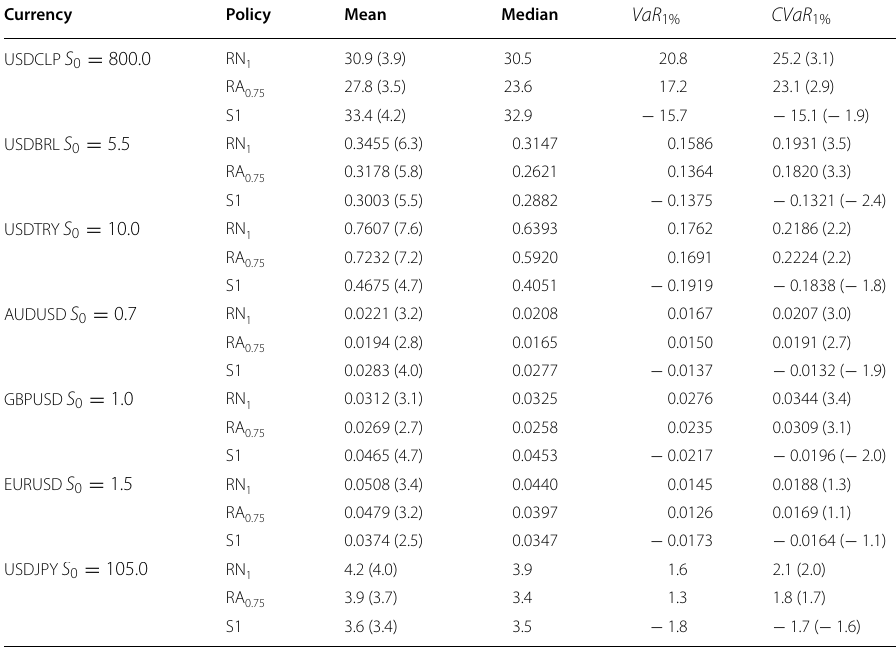
The numbers in parenthesis are the P&L divided by S 0 , that is, the P&L in terms of the foreign currency (US dollar cents for USDCLP, USDBRL, USDTRY, USDJPY, pennies for GBPUSD, euro cents for EURUSD, Australian dollar cents for AUDUSD). We set 2.5% and D π u π d L 1 = = = =